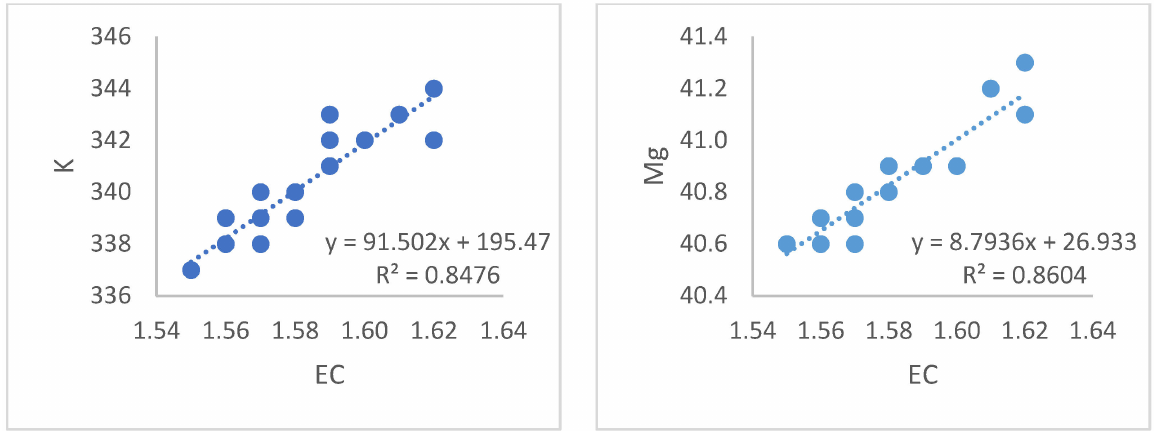
Figure 7. Relationships between the EC values and the K and Mg values of the liquid in the system.